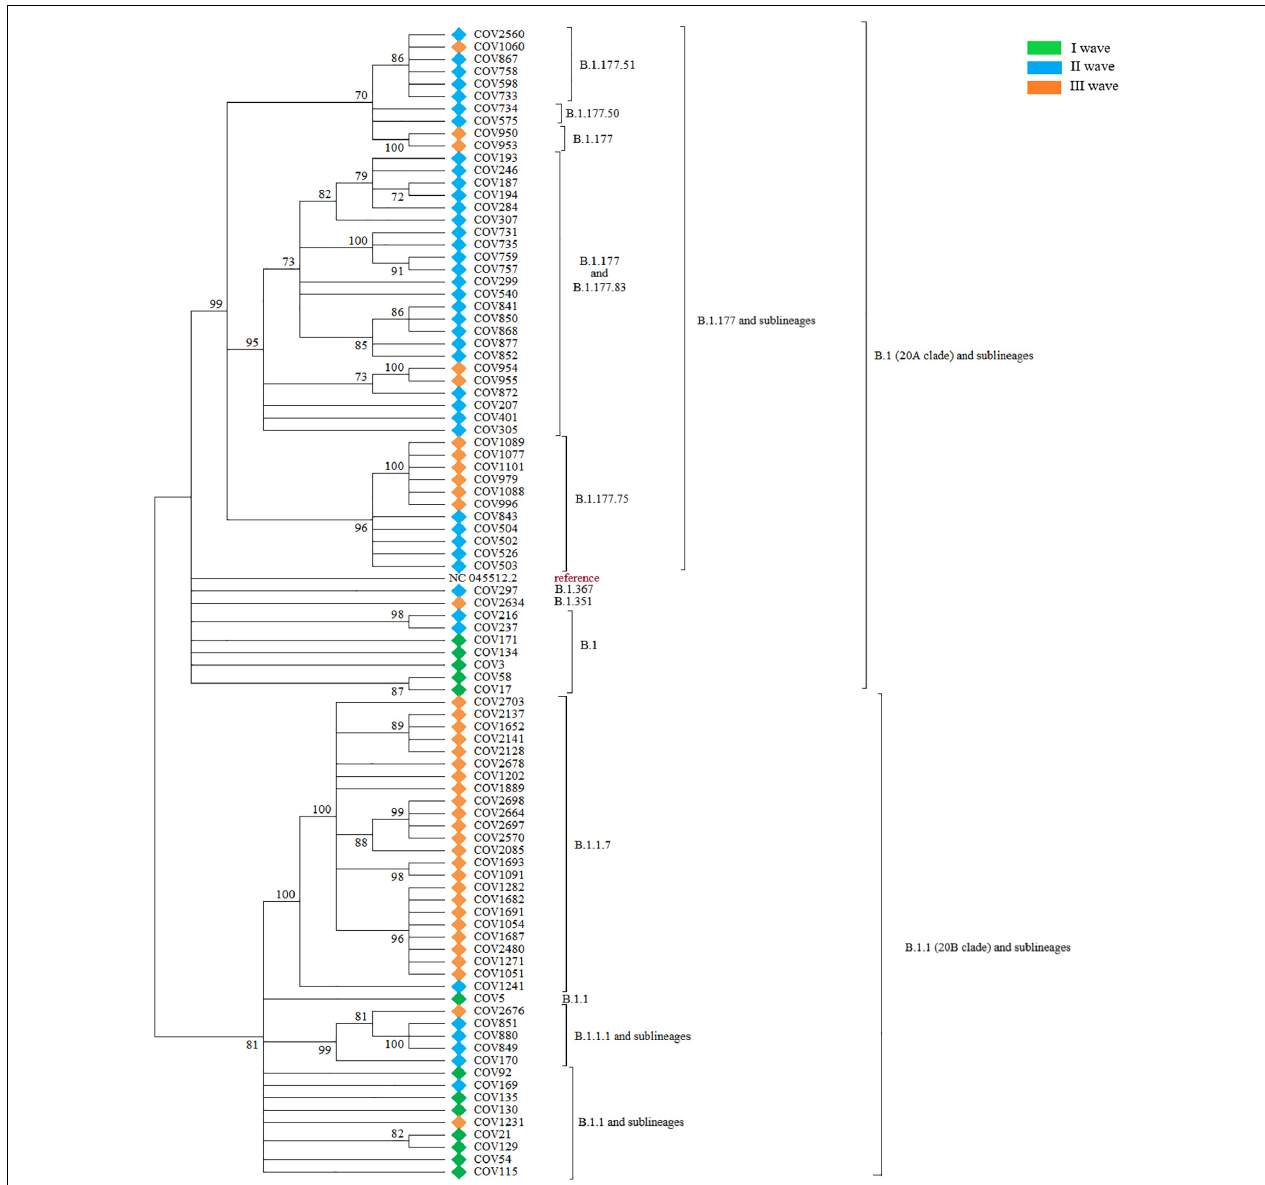
FIGURE 1 | The figure shows the Maximum Likelihood phylogenetic tree obtained on the subset of 92 SARS-CoV-2 selected sequences. Major branches are annotated with the corresponding PANGO lineages and samples are labeled by wave. of remaining sequences was identified as B.1.177 and